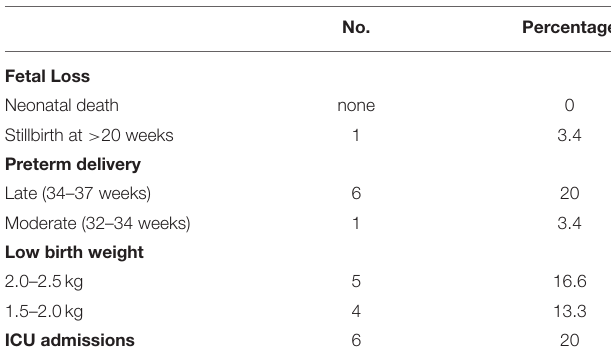
TABLE 5 | Fetal/neonatal outcomes.